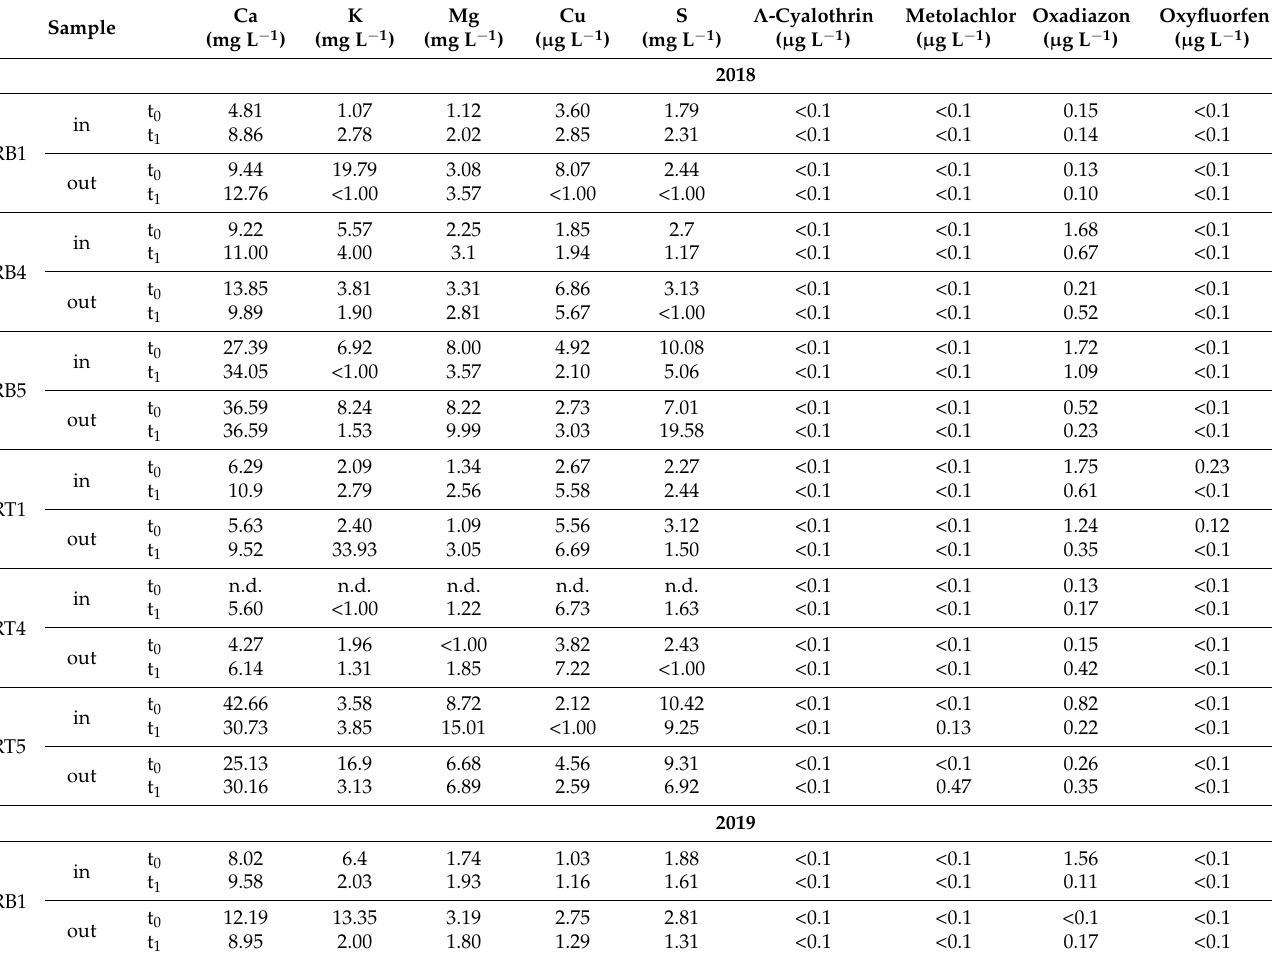
Table 3. Chemical characterization of water samples from rice paddies (RB = organic cultures; RT = conventional cultures). In 2019 RB4 was substitute with RB6 (in = paddy field chamber entrance; out = paddy field chamber exit).